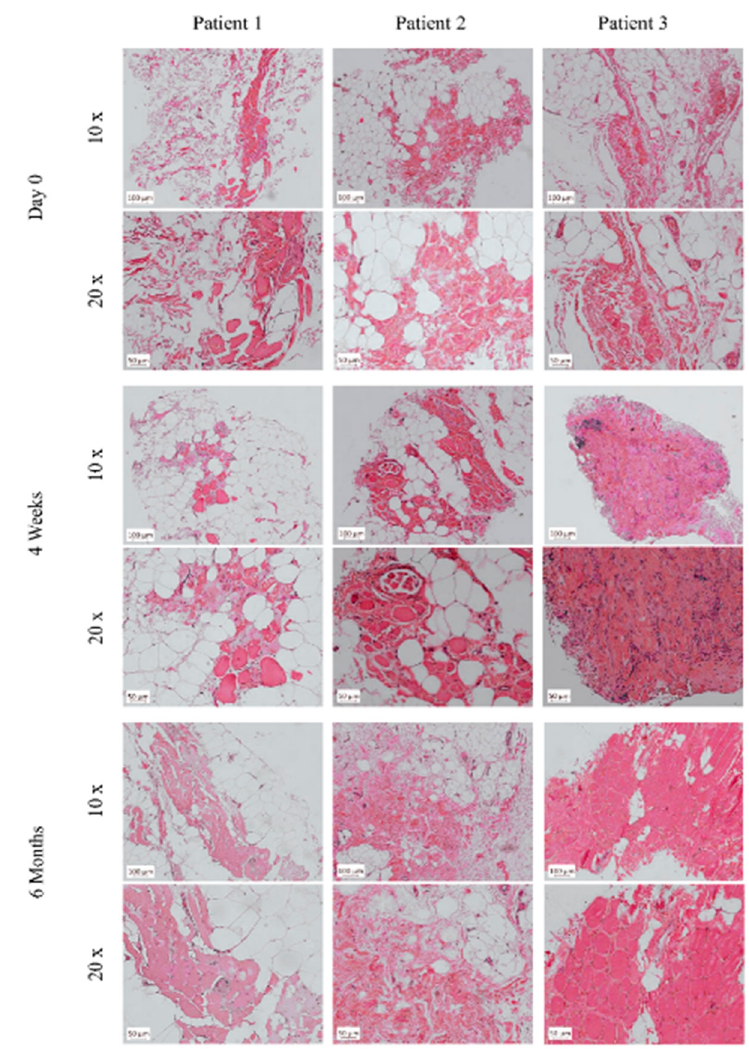
Figure 7. Histopathological changes of skeletal muscles in DMD patients. Muscle biopsies taken from the patients on day 0, before cellular therapy, revealed the predominance of fat or connective tissue; these changes corresponded to Grade 4 according to the Muntoni scale [20]. In the biopsy taken from Patient 1 on day 0, focal muscle fibres were surrounded by fat and connective tissue. However, during the follow-up period after six months, more numerous muscle fibres in the cell-grafted area were present. In the biopsy from Patient 2, on day 0, abundant substitutions by fat and connective tissue were evident. Four weeks after cellular therapy, focal myofibres were detected at the cell-grafted site, however, after six months, only the fibrotic and fat tissues were detected in the examined biopsies. Biopsy taken from patient 3 also revealed only fat and connective tissue at day 0. Four weeks after the cell transplantation, muscle tissue with disrupted muscle fascicles, marked fibrotic tissue and abundant inflammatory infiltrates was visible. Six months after cellular therapy, inflammatory infiltrates between the muscle fibres were very moderate compared to week 4.